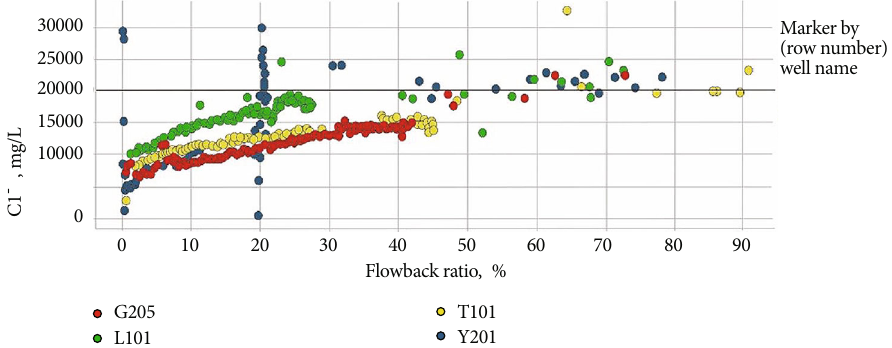
Figure 2: Variation of chlorine content with fl owback ratio in produced water of adjacent wells.